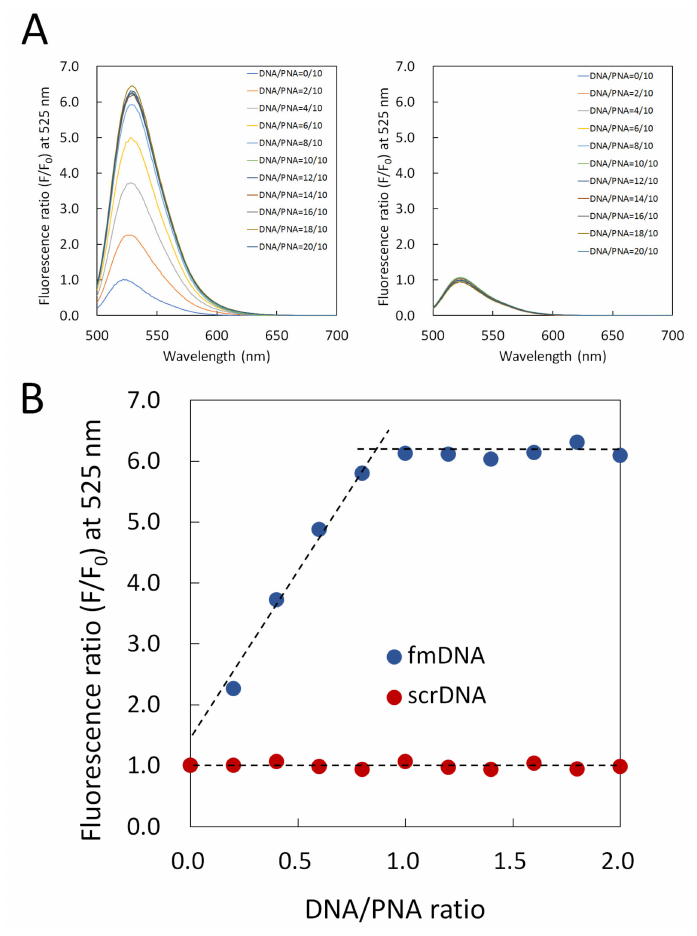
Figure 4. ( A ) Fluorescence spectra of 500 nM P1Q1 with various concentrations of fmDNA ( left ) and scrDNA ( right ). ( B ) Titration curves of fluorescence intensities at 525 nm for P1Q1 /fmDNA (blue-filled circles) and P1Q1 /scrDNA (red-filled